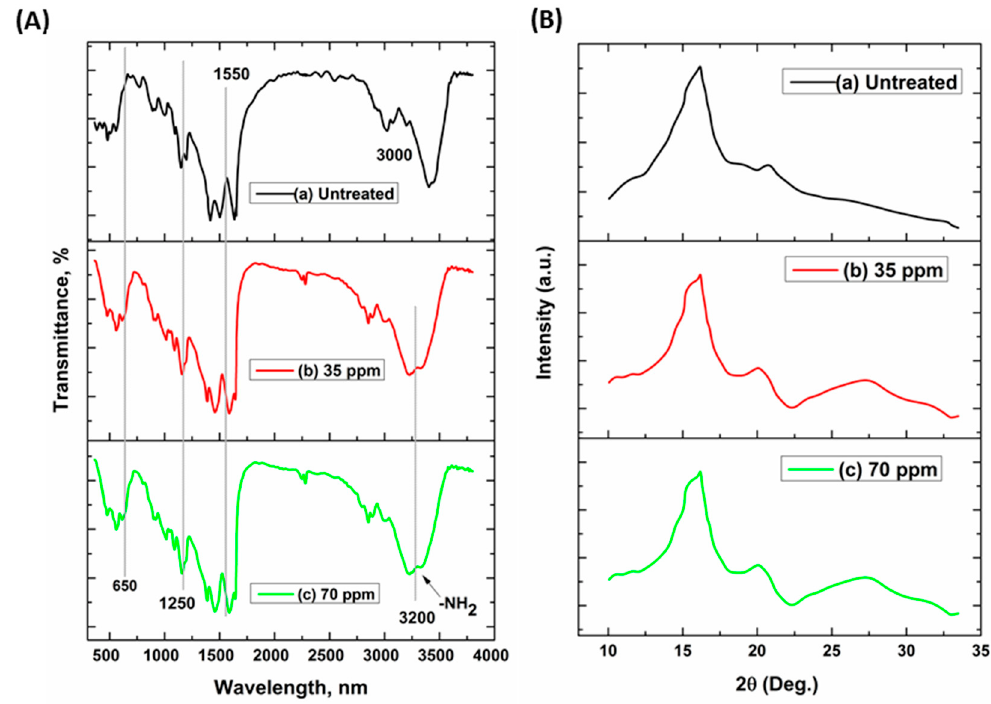
Figure 4. ( A ) FT-IR spectra and ( B ) XRD spectra of the silk; ( a ) untreated, and treated with ( b ) 35 ppm and ( c ) 70 ppm AgNPs at optimized condition.